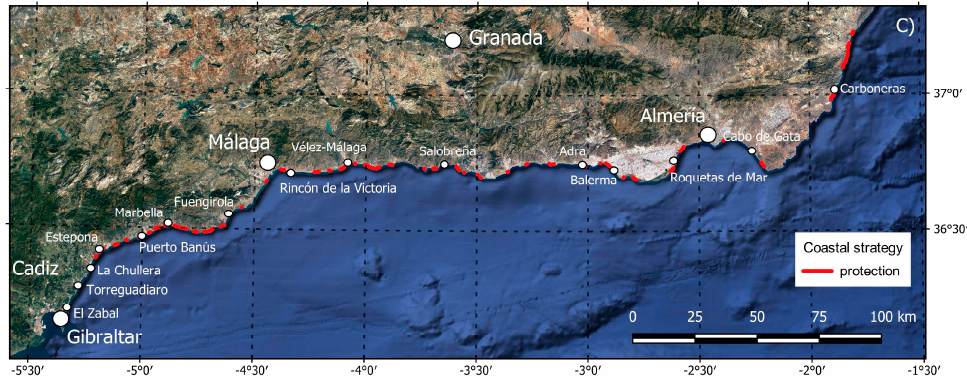
Figure 8. Distribution of response strategies: “do nothing” ( A ), “adaptation” ( B ), and “protection” ( C ).